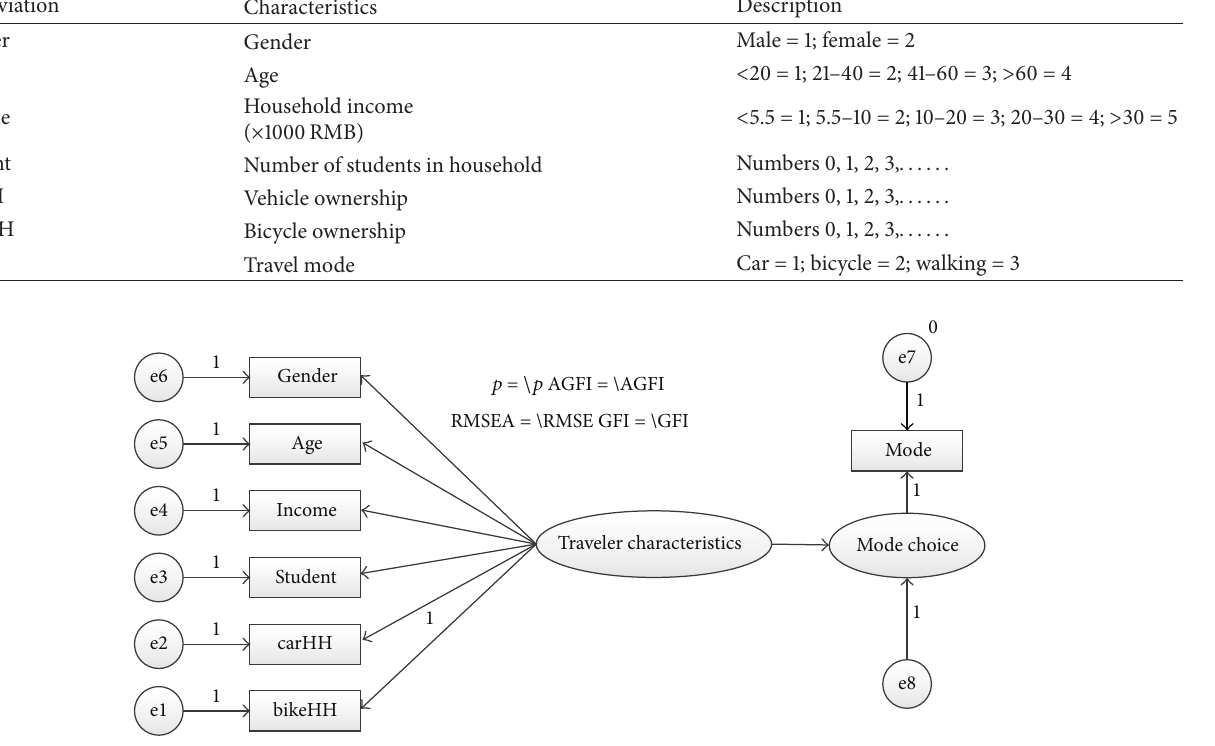
Figure 4: Primary structure of travelers’ characteristics in the